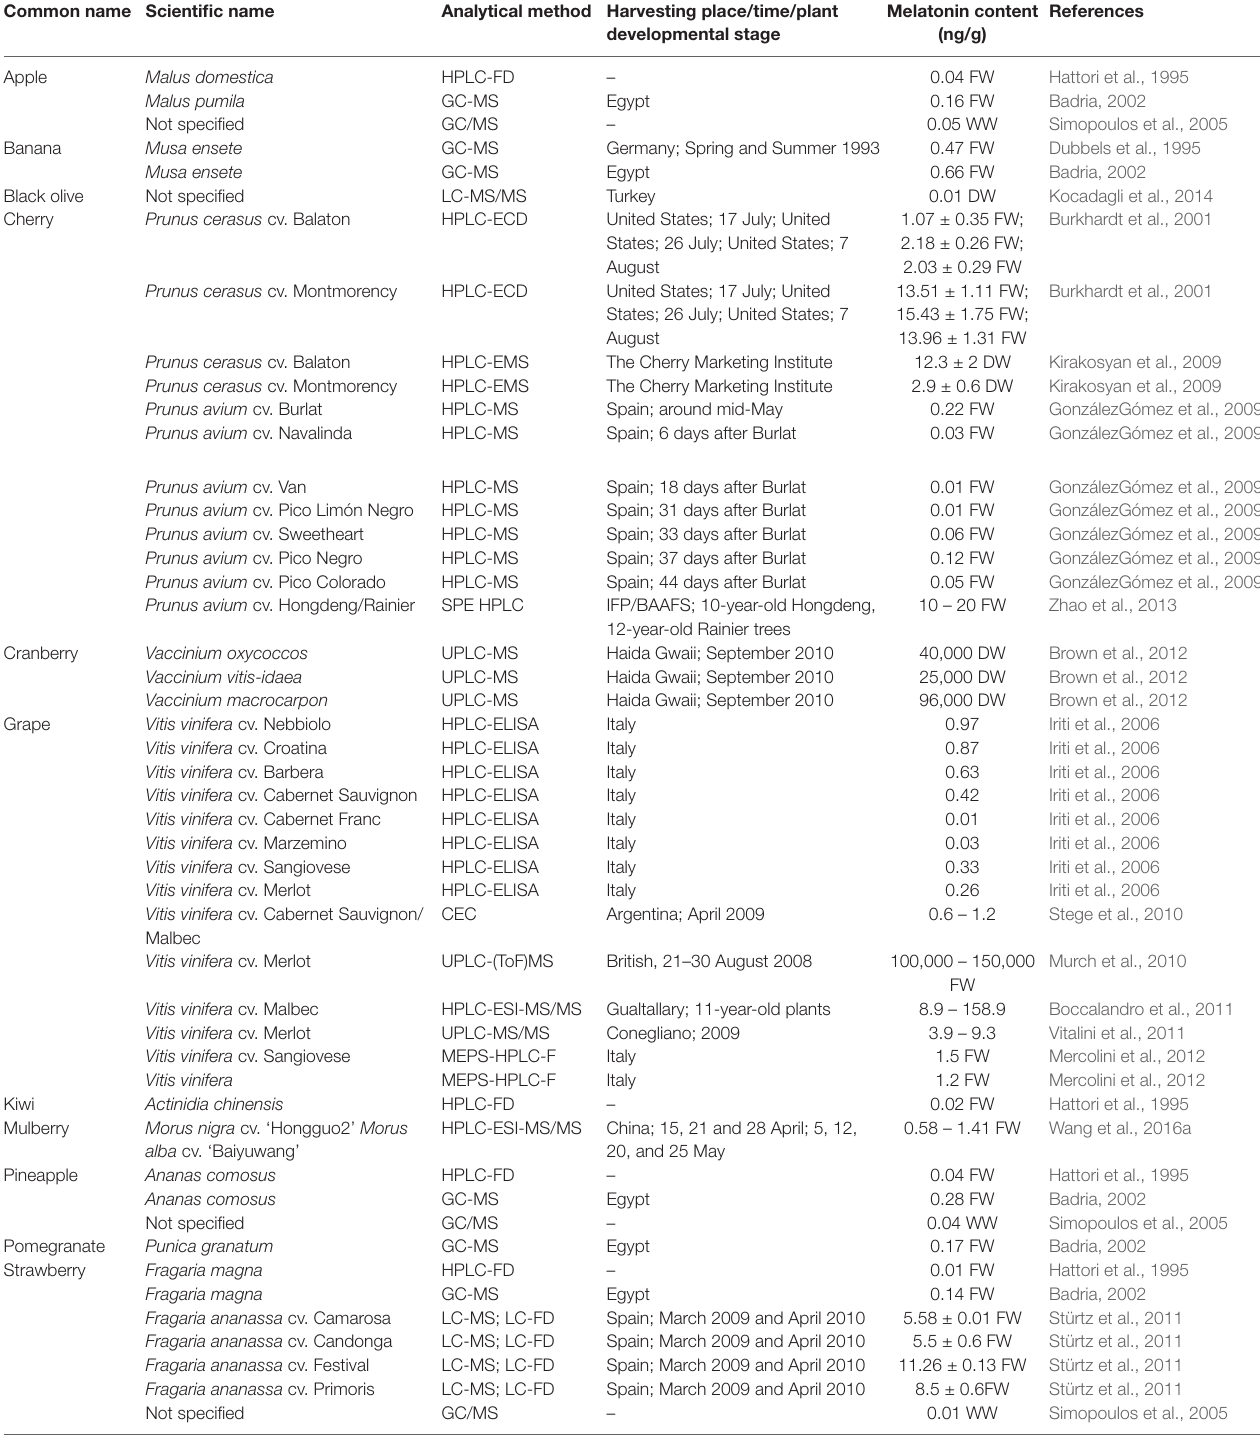
TABLe 1 | Contents of endogenous melatonin in different post-harvest